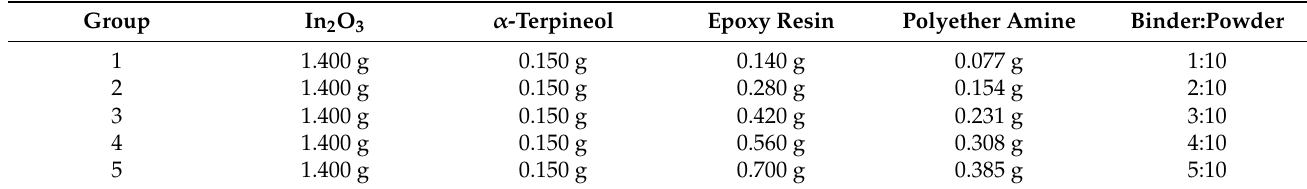
Table 1. The parameters of slurries by using screen printing